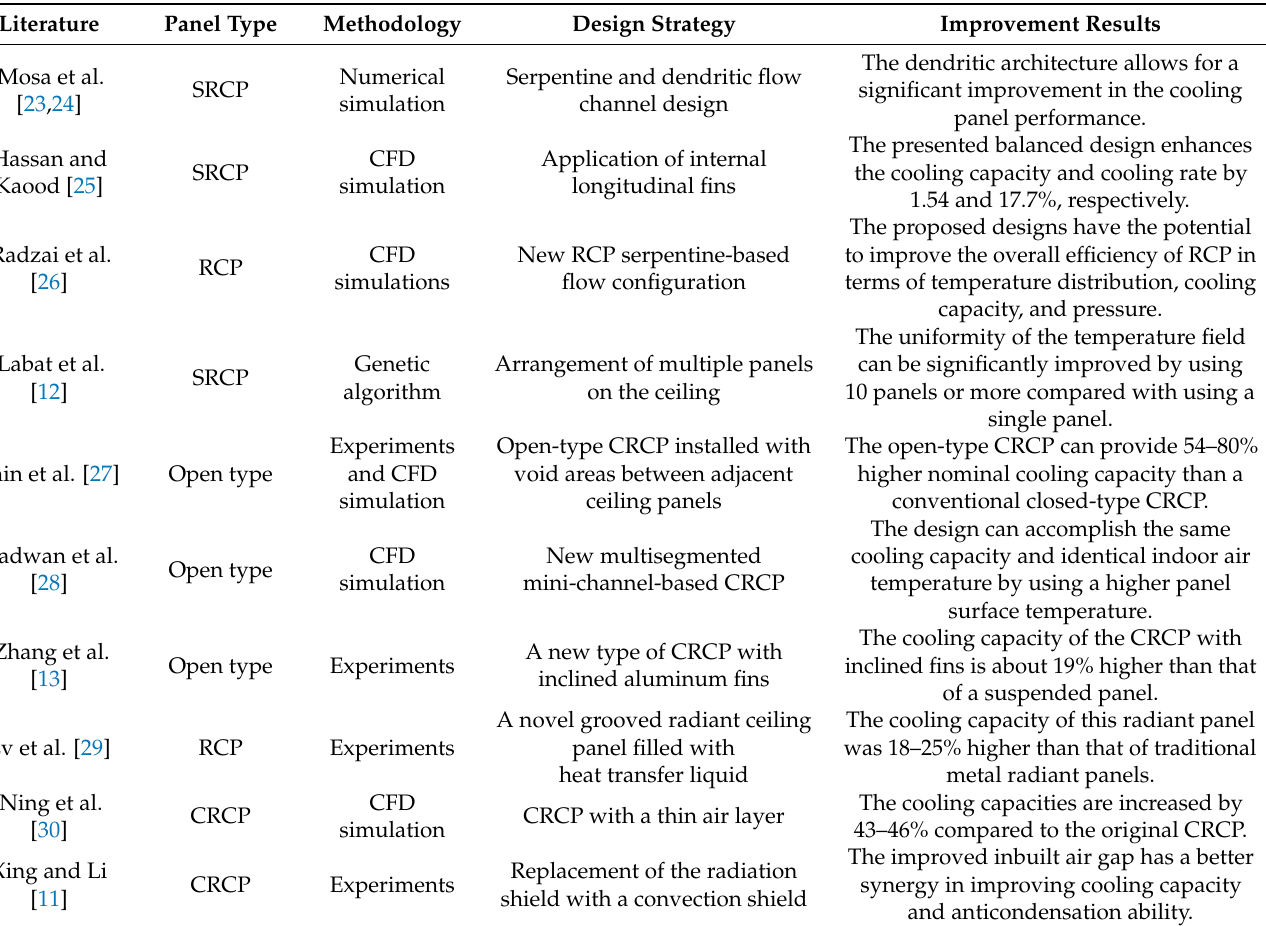
Table 1. Studies on CRCP structure